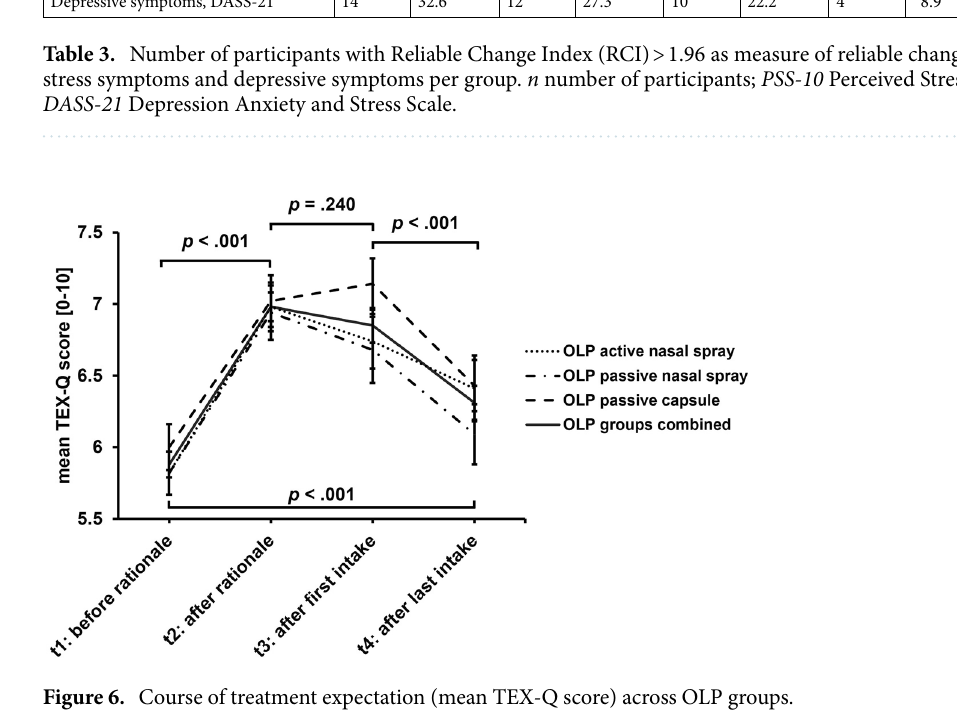
Figure 6. Course of treatment expectation (mean TEX-Q score) across OLP